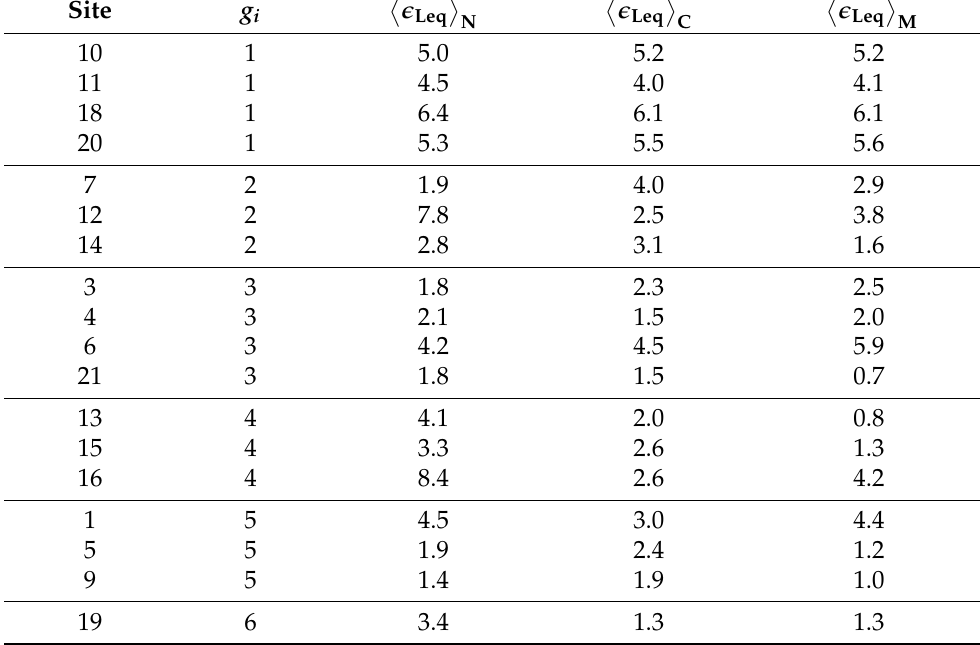
Table 6. Mean local deviations (in dB) of Dynamap predictions from measurements at different sites. The codes of the measurement sites (first column) are indicated by single numbers (see Table 4). The group index g i is given for each site (second column). The remaining three columns report (cid:10) (cid:11) (cid:10) (cid:11) (cid:101) Leq (cid:101) Leq the mean deviations: obtained without systematic error corrections, obtained after N C (cid:10) (cid:11) (cid:101) Leq systematic error corrections have been applied, and corresponding to the median average of M the corrected predictions [91].